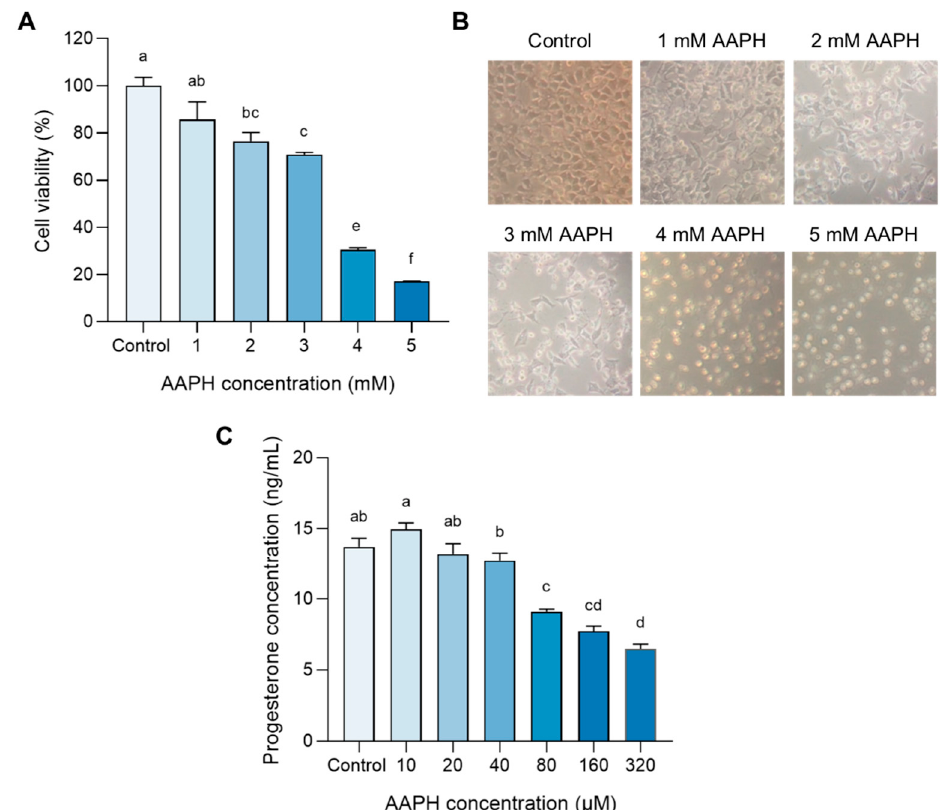
Figure 2. Effect of AAPH on R2C cell viability and progesterone synthesis: ( A ) Cell viability of R2C cells under different concentrations of AAPH, n = 4. ( B ) Representative cell morphology of R2C cells treated with 1, 2, 3, 4, and 5 mM AAPH. ( C ) Progesterone showed a dose-dependent decrease in AAPH concentration within 320 µ M, n = 6. All data were analyzed for differences by one-way ANOVA. Different letters indicated that there is a significant difference ( p < 0.05).